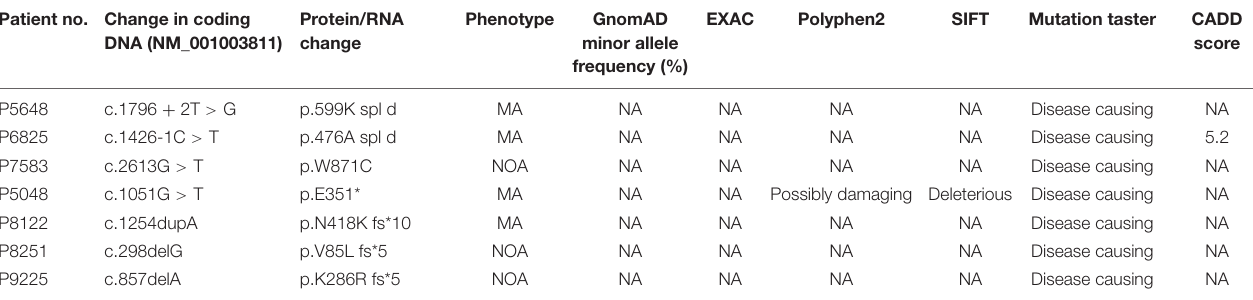
TABLE 2 | In silico analysis of the novel pathogenic variants of TEX11. Patient no. Change in coding Protein/RNA DNA (NM_001003811) change